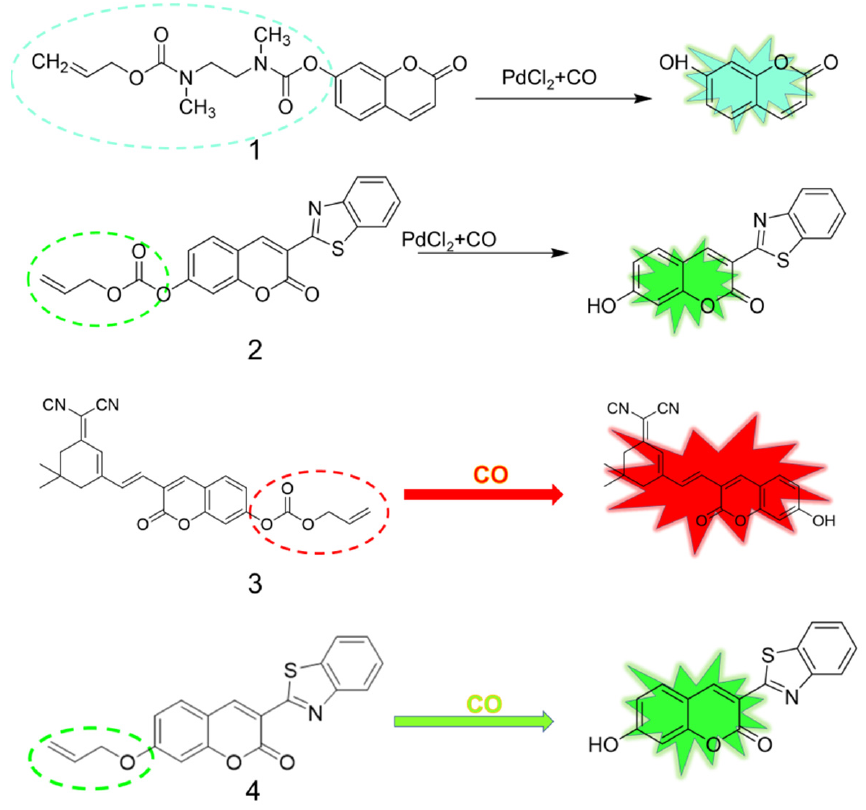
Figure 4. Some CO fluorescent probes constructed on the basis of coumarin fluorophores and their reaction detection